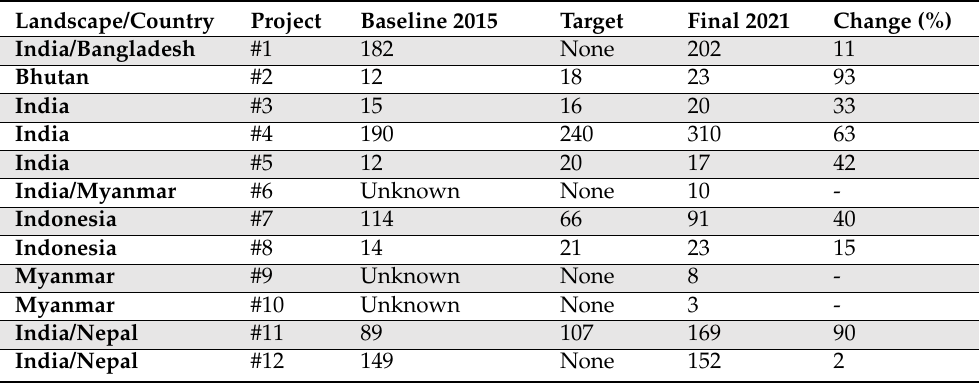
Table 2. Overview of change in tiger populations in each ITHCP project displayed in absolute numbers and